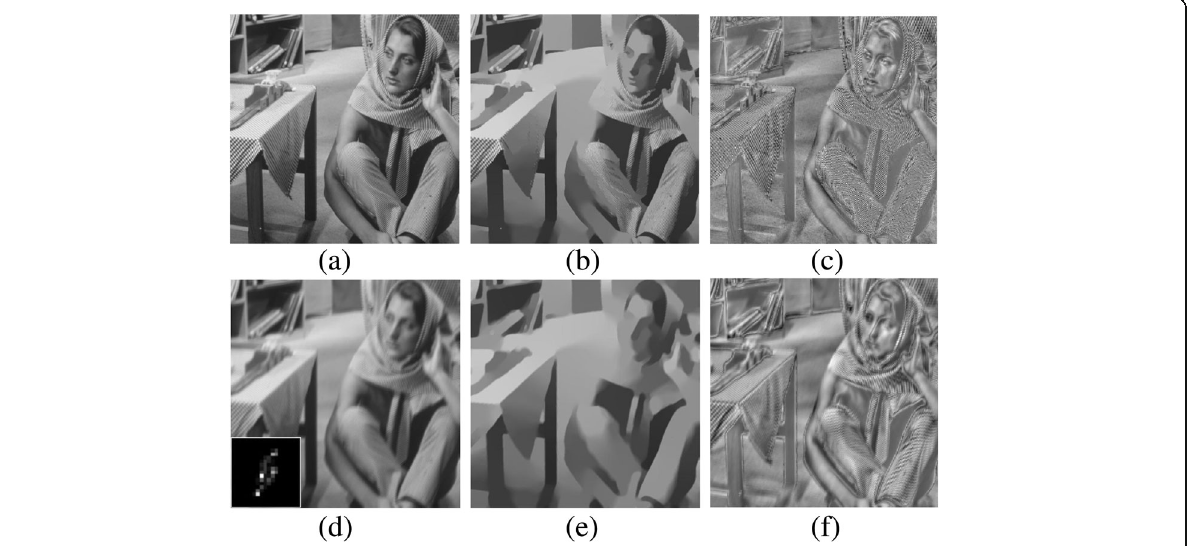
Fig. 1 Image regions division. a Original image. b Edges and constant regions of ( a ). c Details of ( a ). d Blurred image(PSNR = 19.24). e Edges and constant regions of ( d ). f Details of ( d